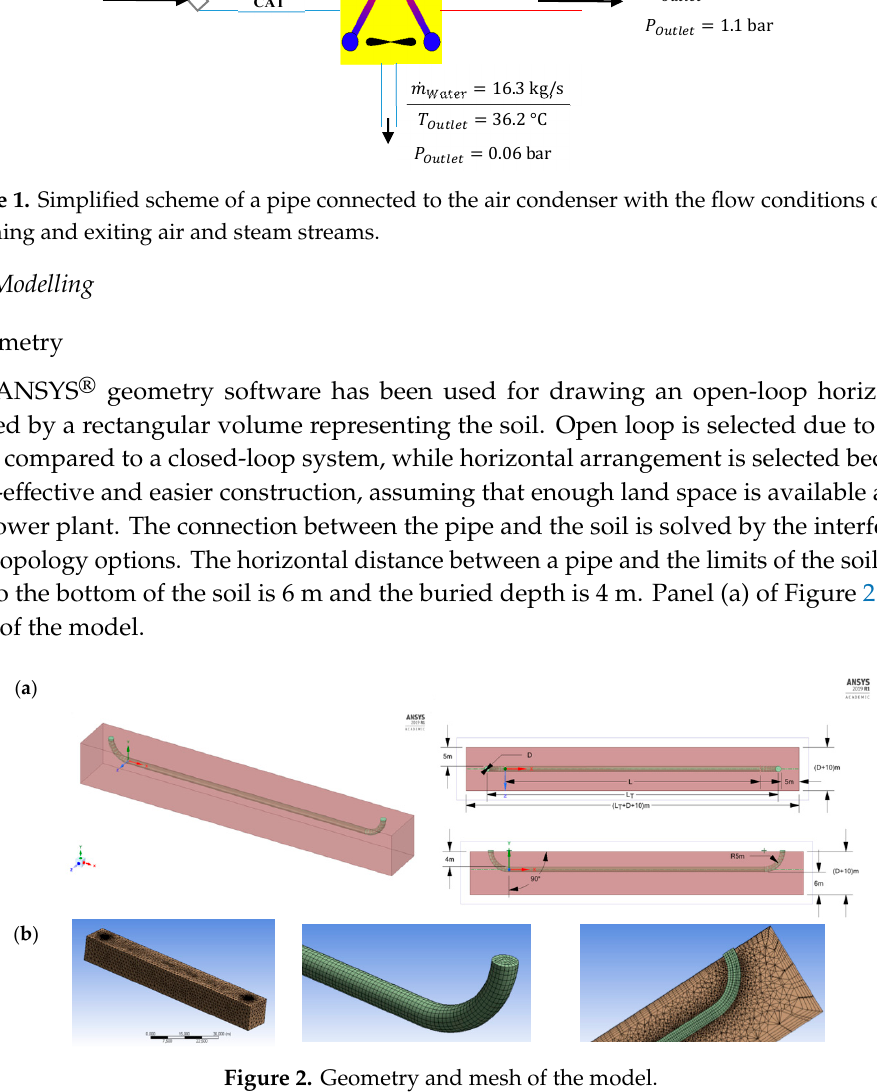
Figure 2. Geometry and mesh of the model.